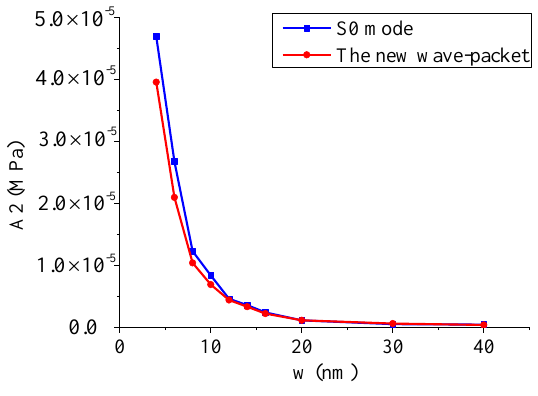
Figure 15. Relationship between the amplitude of the second harmonic component and the width of a micro-crack for both the S0 mode wave-packet and the new wave-packet. The blue curve represents the relationship for the S0 mode wave-packet, and the red curve represents the relationship for the new wave-packet. A2 represents the amplitude of the second harmonic; w represents the width of a micro-crack.